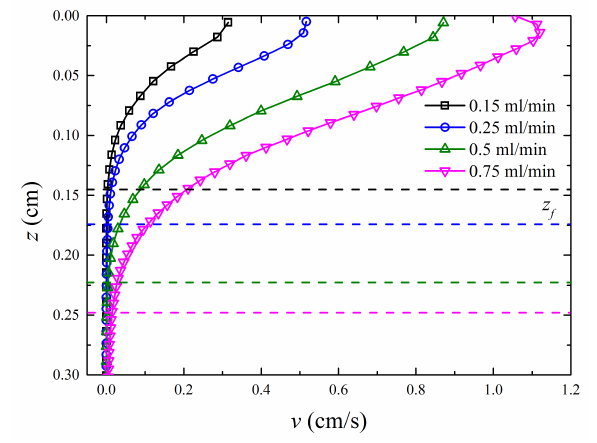
Figure 4. Velocity profiles normalised with Gaussian parameters v 0 and σ . The black solid line is Equation 3. Points are as shown by the legend in Figure 3.